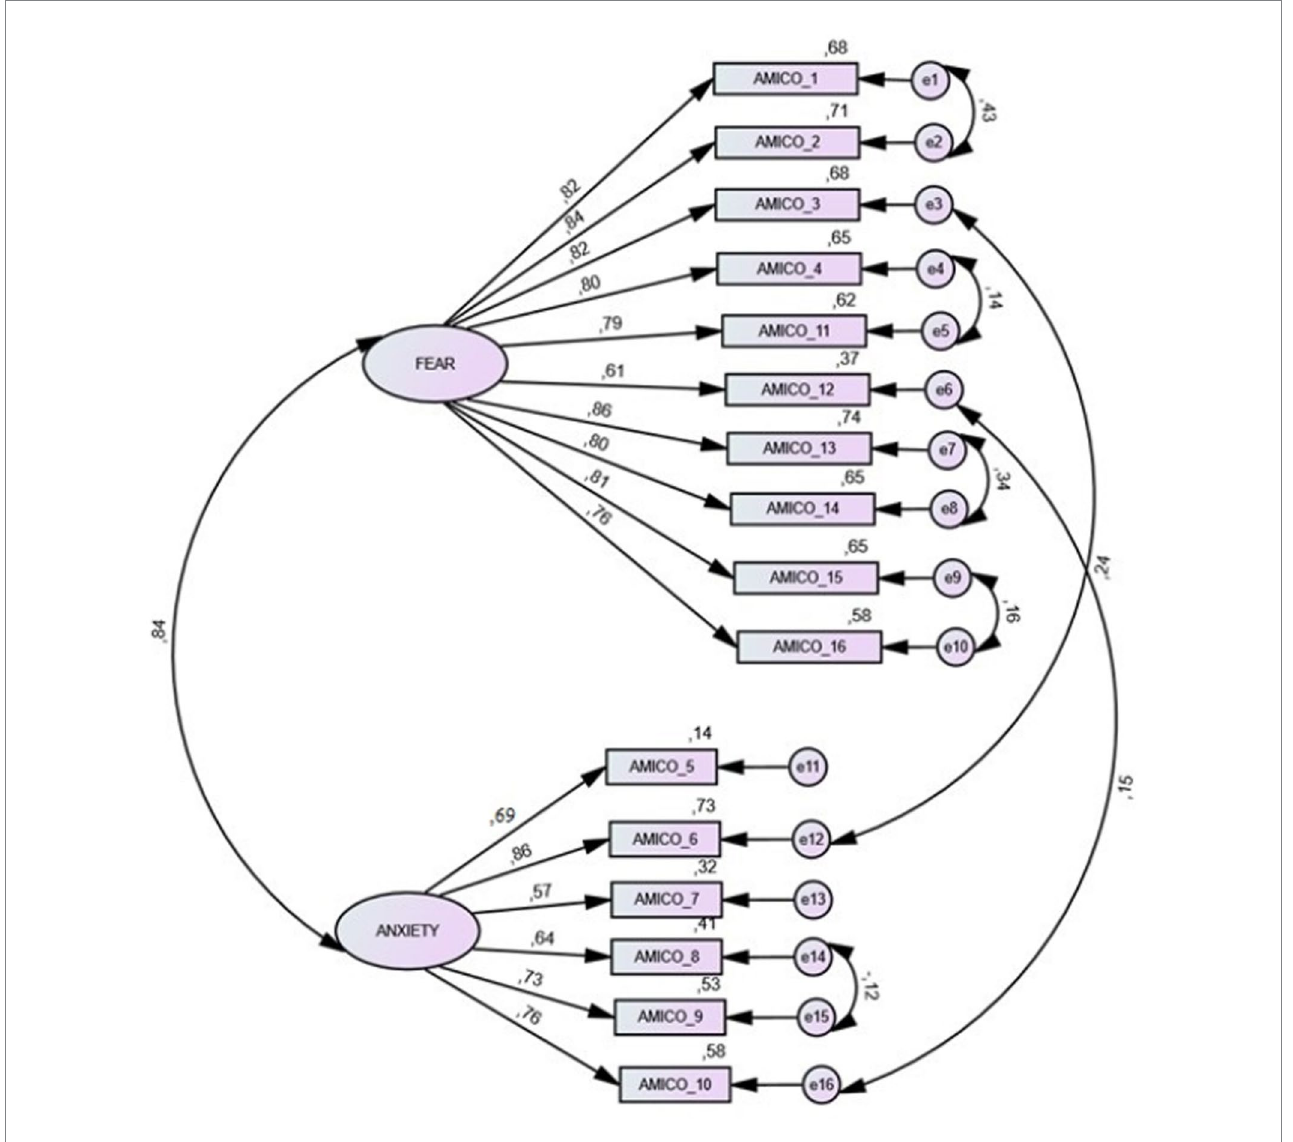
FIGURE 1 Confirmatory factor